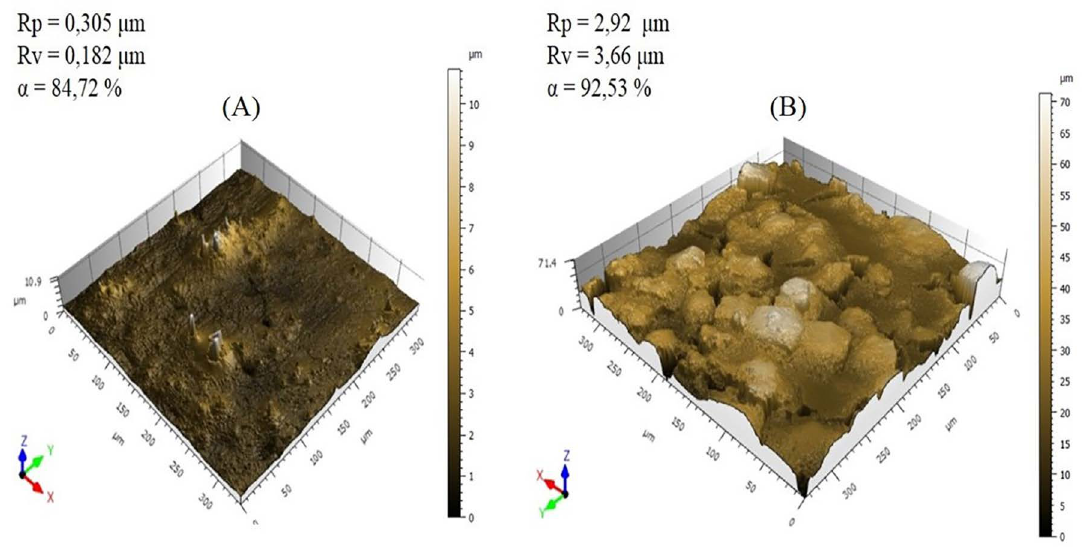
Figure 4. Surface Profilometry of sample 1, without (A) and with (B) the AR